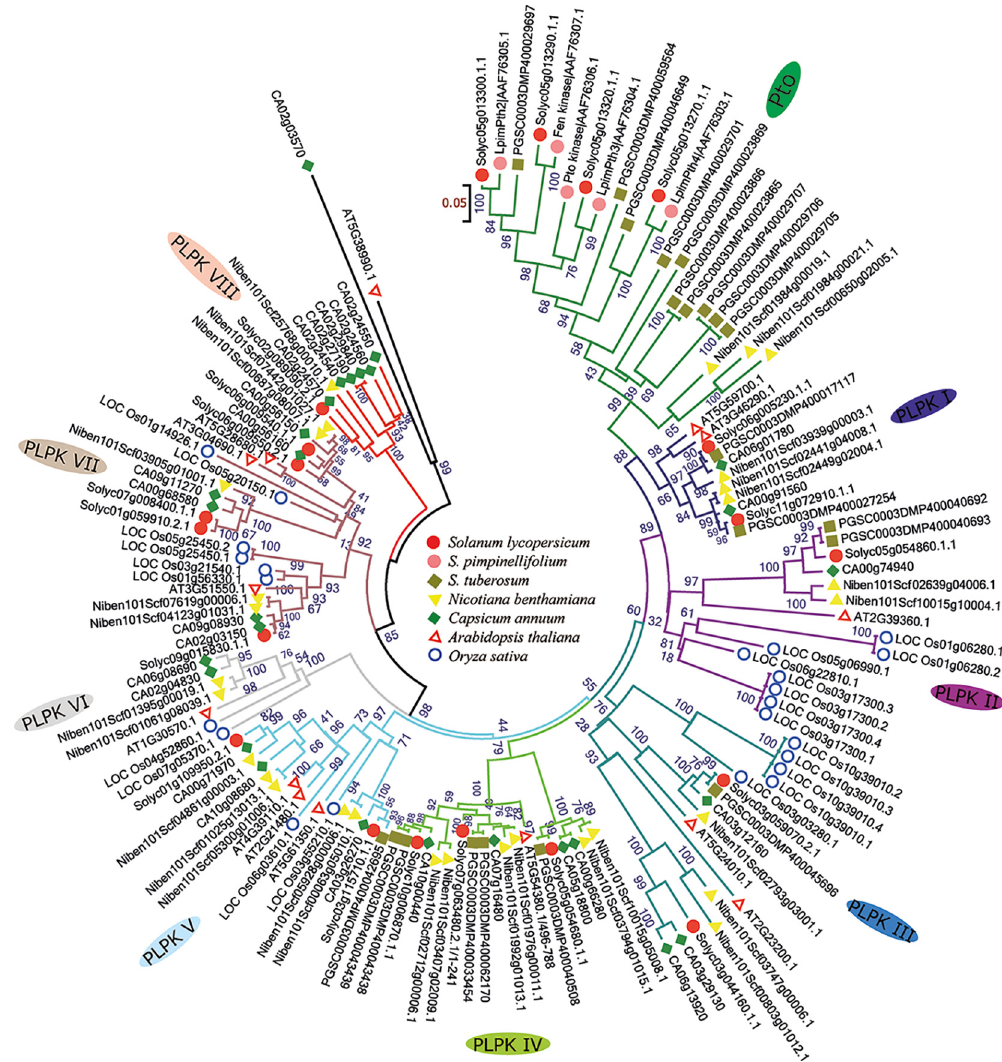
Fig 2. Phylogenetic analysis of tomato Pto paralogs and PLPKs. A rooted phylogenetic tree was constructed using the predicted pepper PLPK sequences and full-length Pto proteins from tomato, N . benthamiana , potato, Arabidopsis and rice. The phylogenetic tree was constructed using the NJ method (1000 bootstrap replicates) as implemented in the MEGA 6.0 software. The name is indicated next to each subclass. Pto-like proteins from various plant species are classified into two main classes, Pto and PLPKs. PLPKs are further divided into eight subclasses (PLPK I-PLKPK